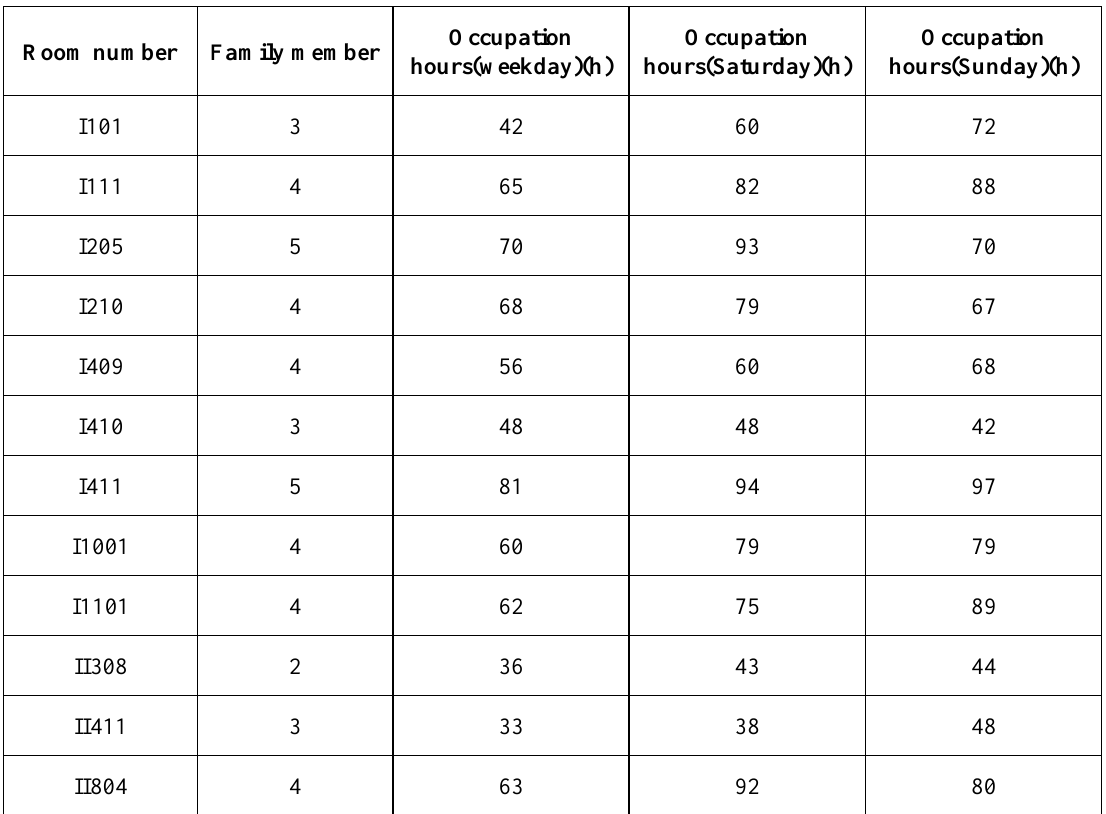
Figure 2. Structure of residential household with heat pump water heater system. Table 1. Basic information of